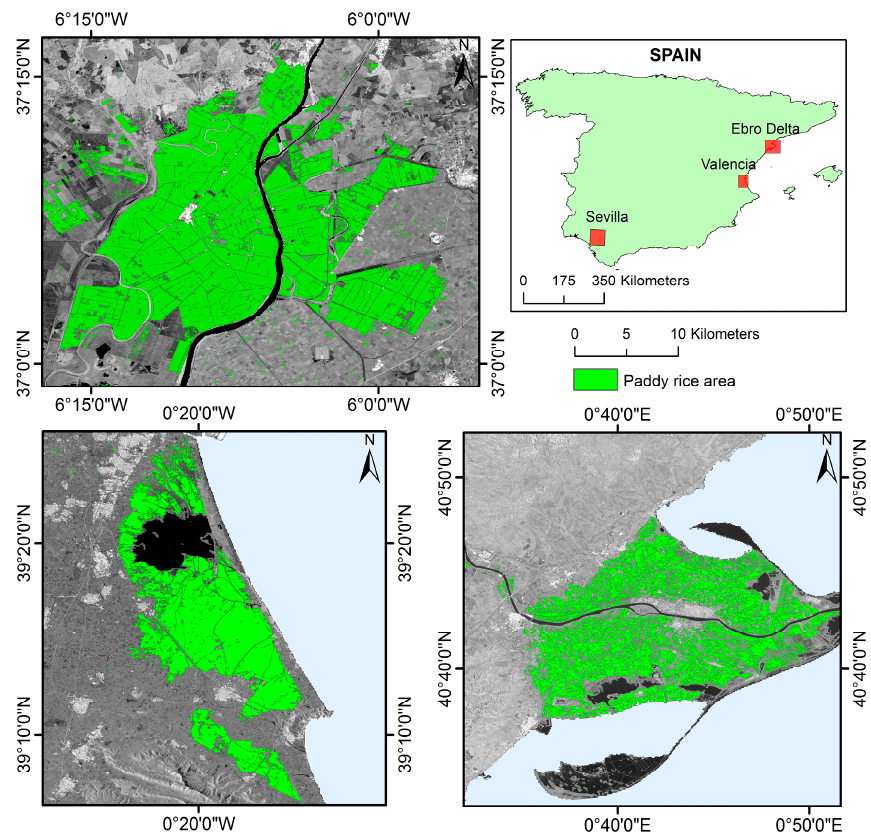
Figure 10. Rice cropland mapping in Spain.